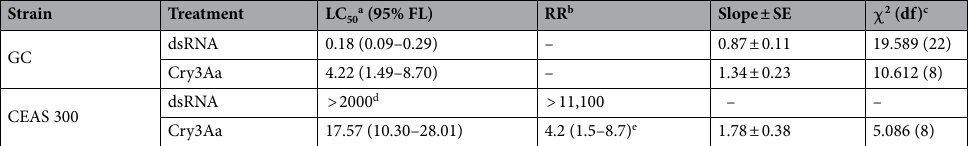
Table 2. Concentration–response bioassays of GC and CEAS 300 Leptinotarsa decemlineata strains to dsRNA targeting the V-ATPase subunit A gene (dsRNA) and Cry3Aa protoxin from Bacillus thuringiensis (Cry3Aa) in leaf bioassays. a LC 50 values expressed in μg/ml. b Resistance Ratio, estimated for dsRNA as the ratio of the LC 50 value for GC to the highest dose tested without mortality for CEAS 300 (2,000 µg/ml); and for Cry3Aa protoxin as the lethal concentration ratio estimated by probit analysis in the POLO-PLUS program. c Chi square ( χ 2 ) value and degrees of freedom (df) from fitting the data to the probit model. d No significant mortality when compared to controls was detected at 2,000 µg/ml (highest dsRNA dose tested). e Resistance ratio and 95% confidence intervals (in parenthesis) calculated using POLO-PLUS as described in Materials and